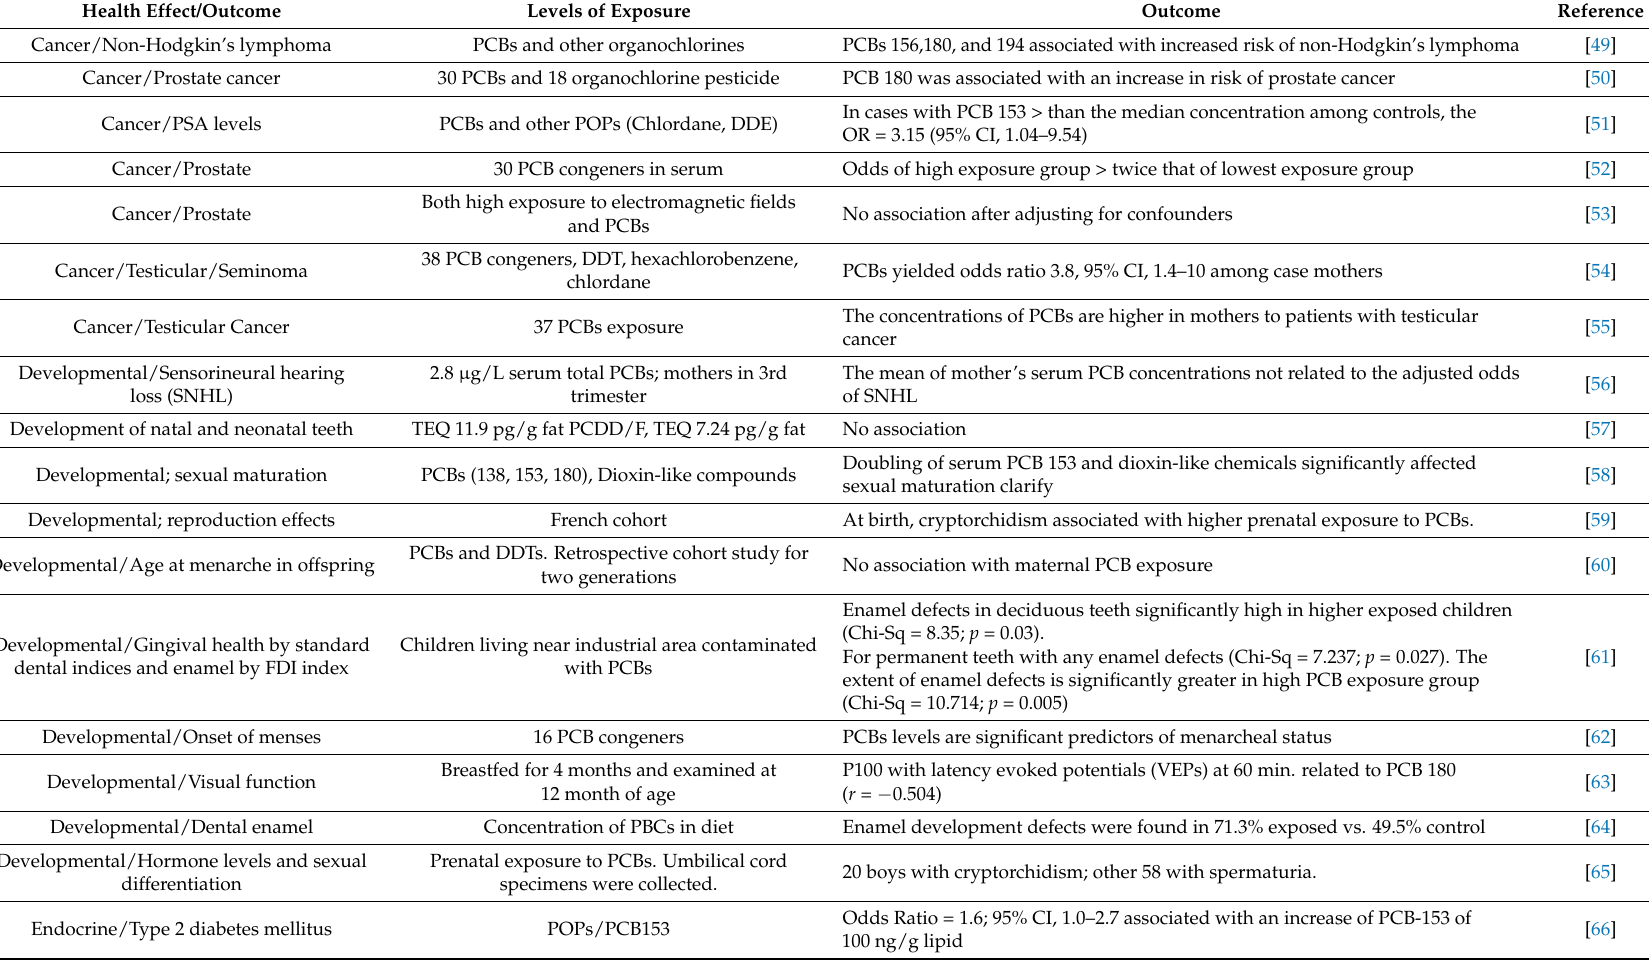
Table 2. Summary of recent epidemiologic studies of human exposures to PCBs [9]. Copyright PMC